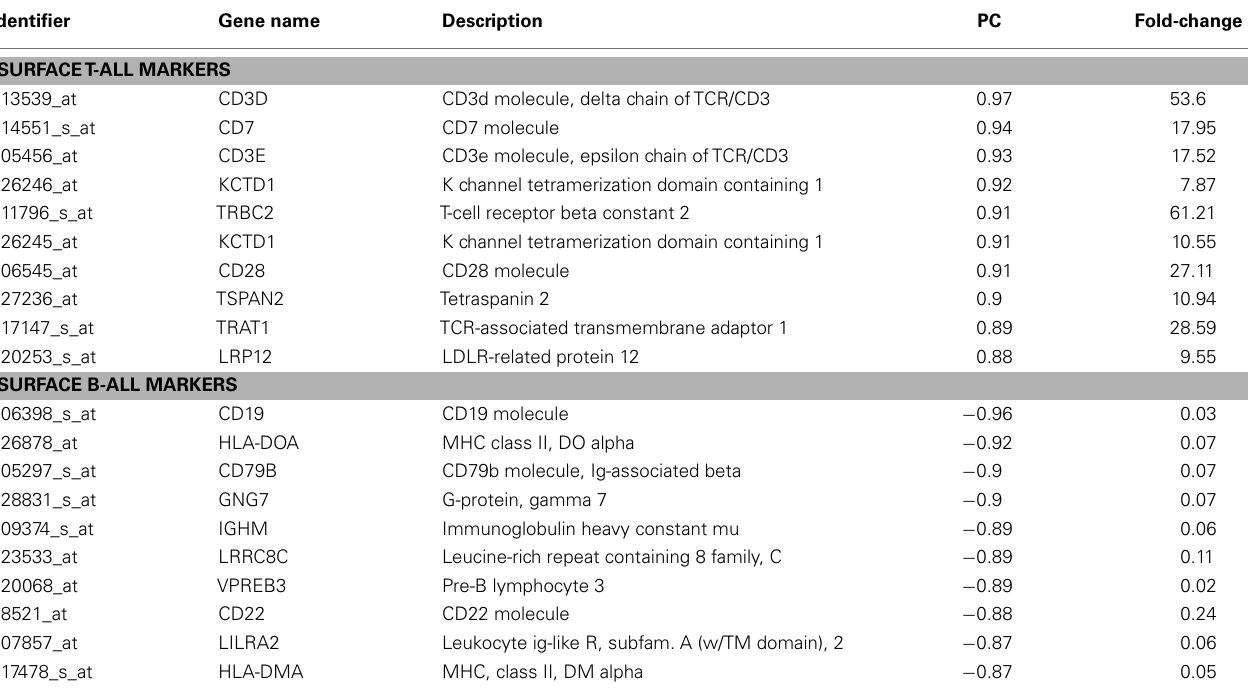
Table 1 |Top 10 cell surface genes driving classification .